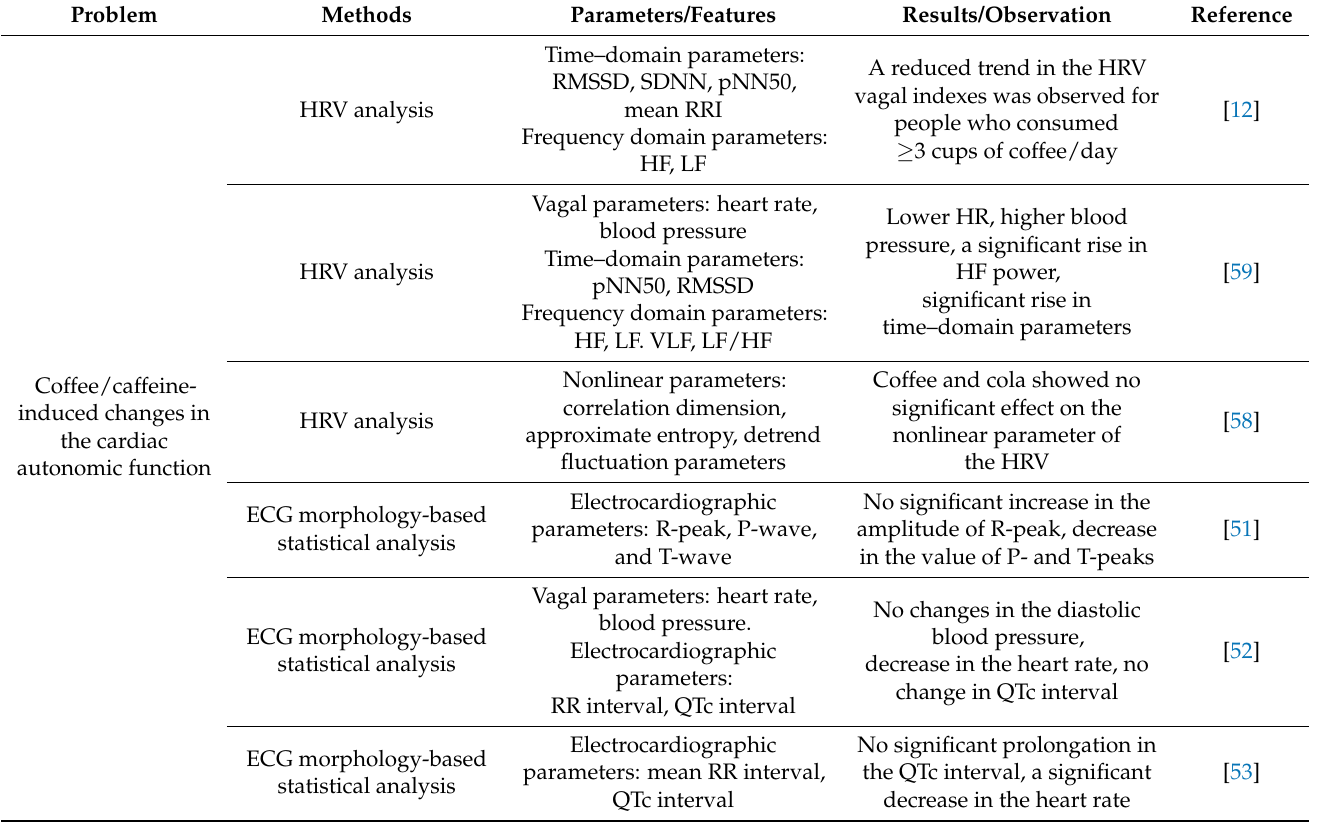
Table 5. Comparison of the various studies on the detection/classification of coffee/caffeine-induced changes in the cardiac autonomic and electrocardiographic